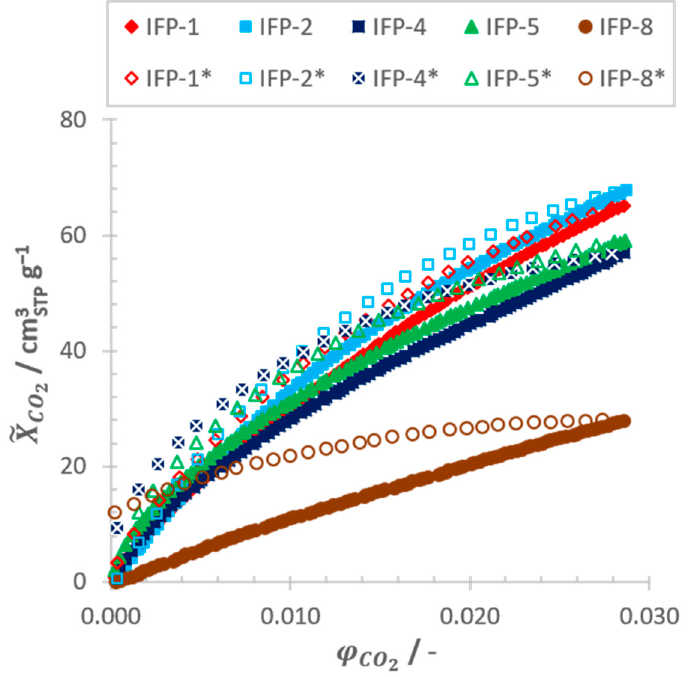
Figure 6. Adsorption and desorption (*) isotherms of CO 2 on all IFP samples at T = 273.15 K.